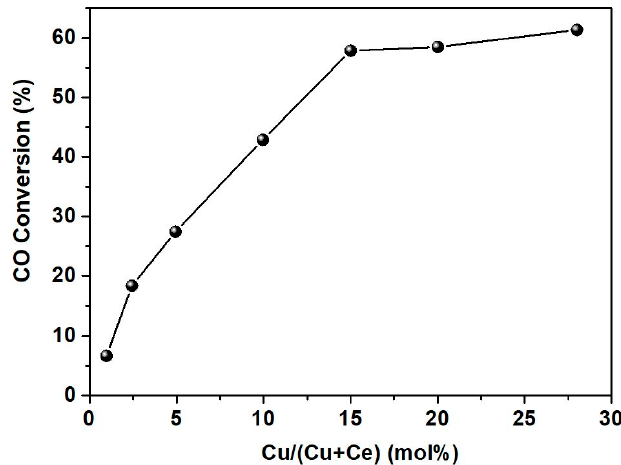
Figure 21. Low-temperature WGS reaction over the Cu/CeO 2 catalysts. CO conversion as a function of the copper content in the respect catalysts. Reaction conditions: 1.0 vol.% CO/3.0 vol.% H 2 O/He, 40,000 h − 1 , 200 °C. Adapted from Reference [286]. Copyright© 2019, Elsevier.